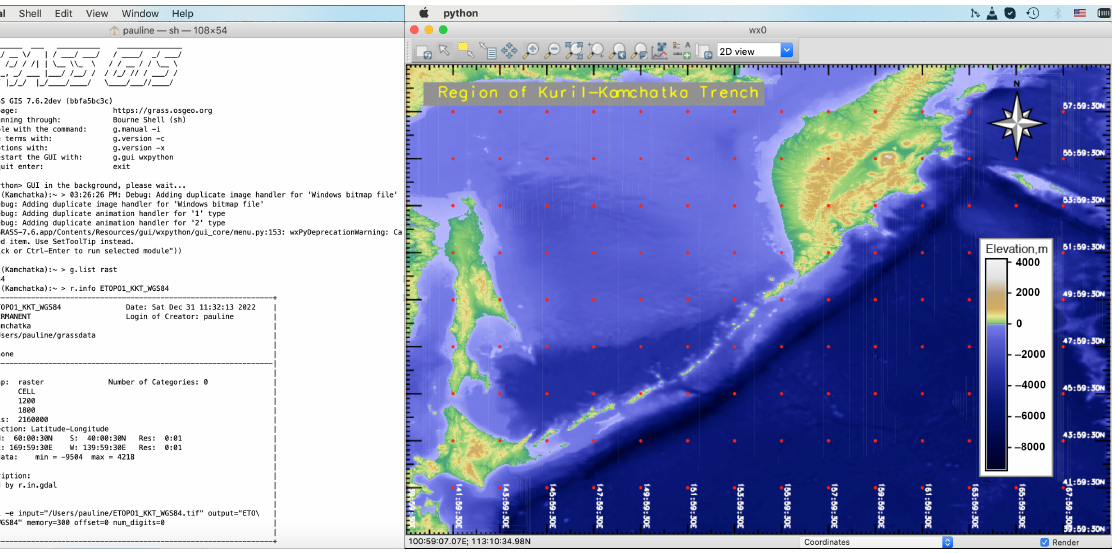
Figure 3. Raster projected from XY to WGS84 Lat/Lon coordinates with cartographic elements. Source: